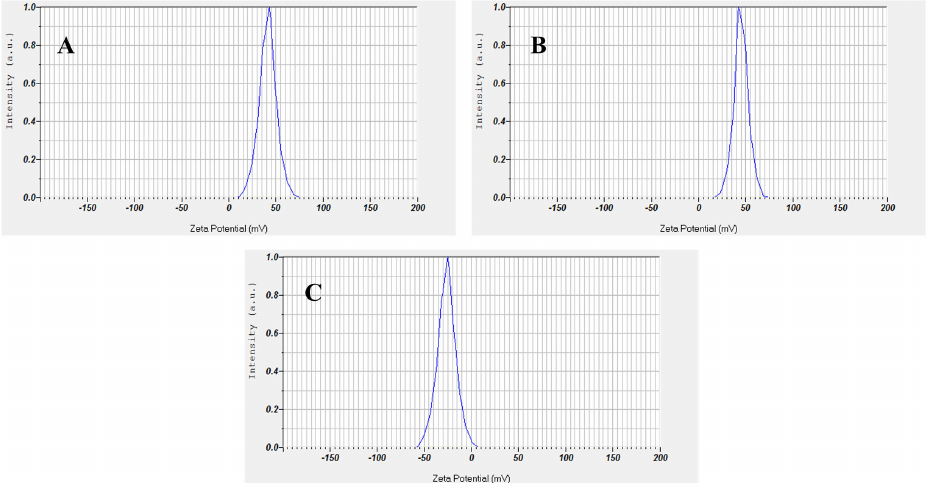
Figure 6. The zeta potential of ( A ) beta ‐ CD, ( B ) bismuth oxide nanoparticles, and ( C ) bismuth oxide nanoparticles with biotinylated beta ‐ CD.